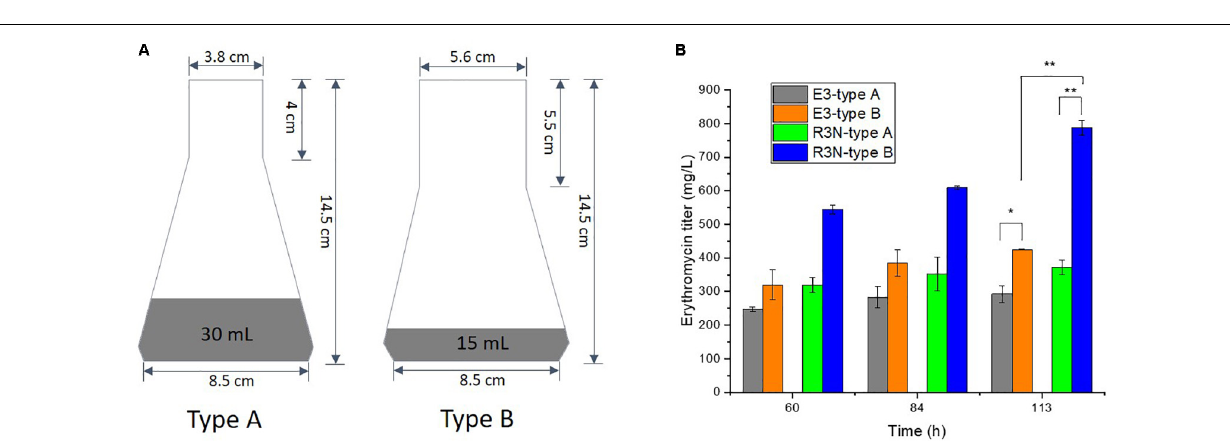
FIGURE 5 | Effect of oxygen supply on the production of erythromycin by E3 and R3N. We used two types of shake flasks with different amounts of medium that is 30 mL for type A and 15 mL for type B (A) , resulting in differential erythromycin increase for E3 and R3N before and after increasing oxygen supply (B) . Data are shown as mean ± standard deviation from at least three independent experiments. *, P -value < 0.05; **, P -value <